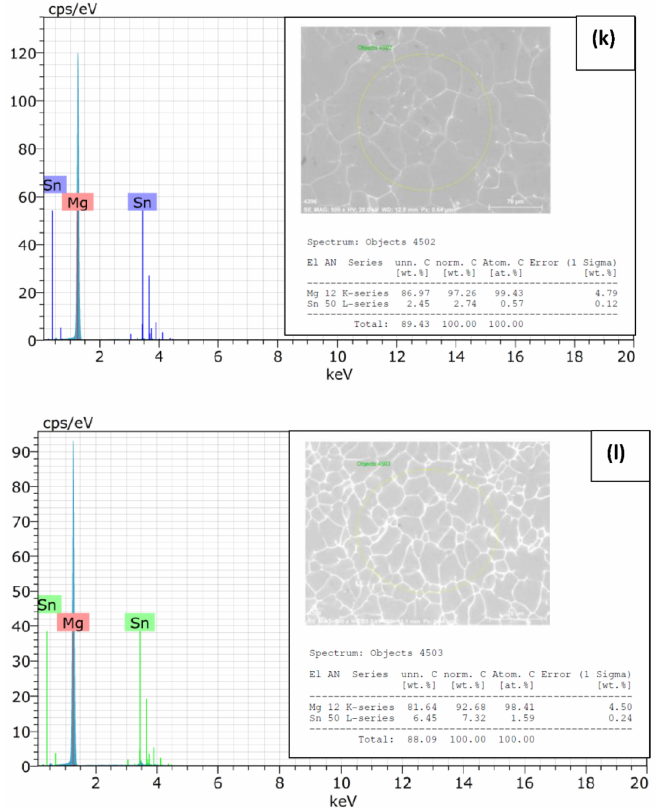
Figure 3. EDS elemental mapping of ( a – c ) Mg-1Sn; ( d – f ) Mg-5Sn; ( g – i ) Mg-10Sn alloys and EDS spectra of ( j ) Mg-1Sn; ( k ) Mg-5Sn; ( l )